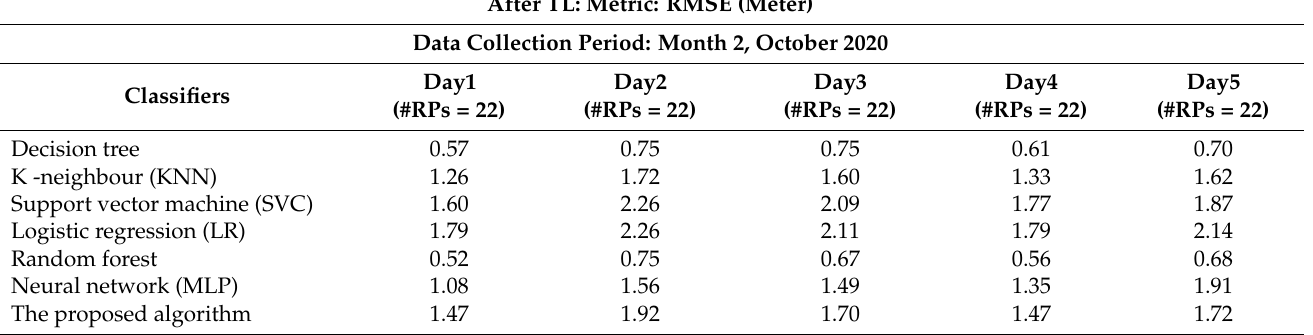
Table 9. Models vehicle’s indoor parking lots of CSI-based fingerprints of various datasets with different temporal